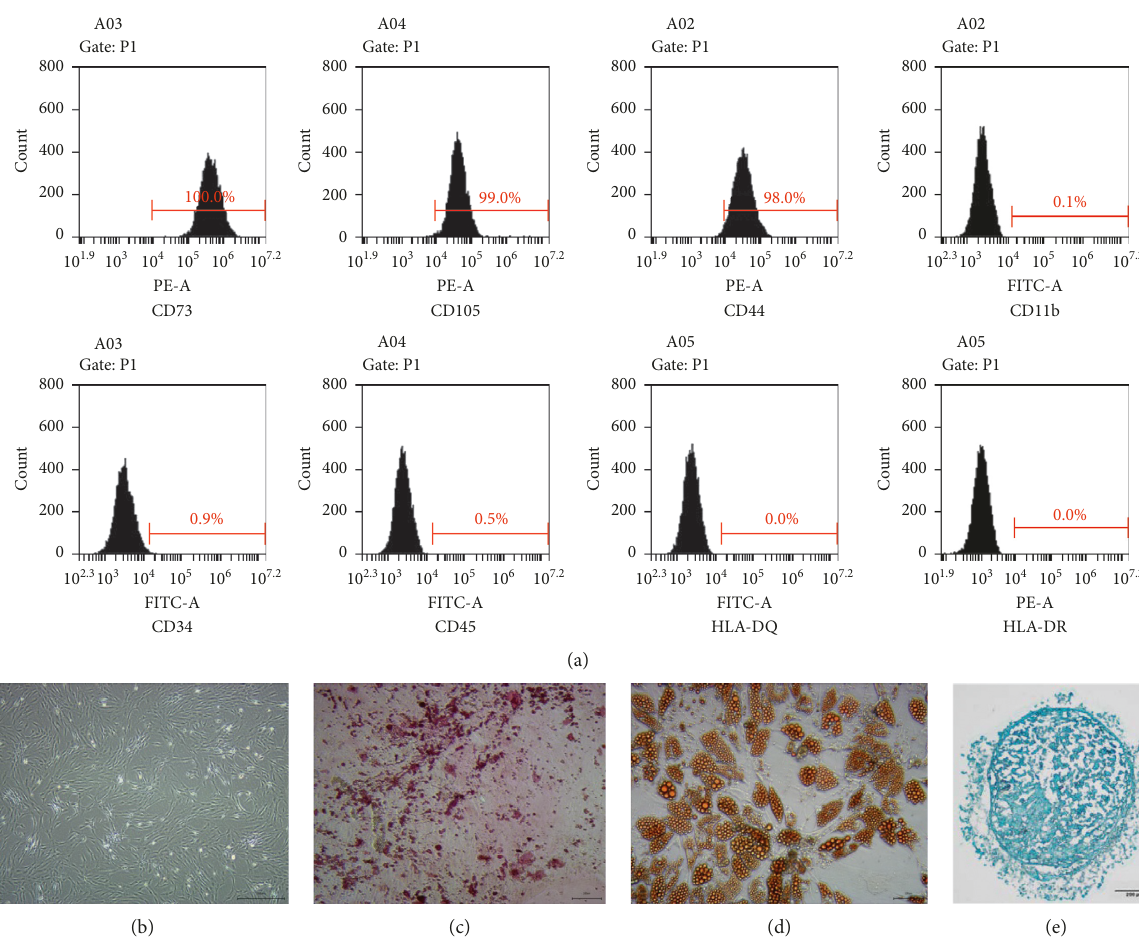
Figure 1: The cells were identified as ADSCs. (a) Surface markers of ADSCs were assayed by flow cytometry analysis. (b–e) The adipogenic, osteogenic, and cartilage differentiations of ADSCs were assayed by Oil Red O staining, Alizarin red-S staining, and Alcian blue